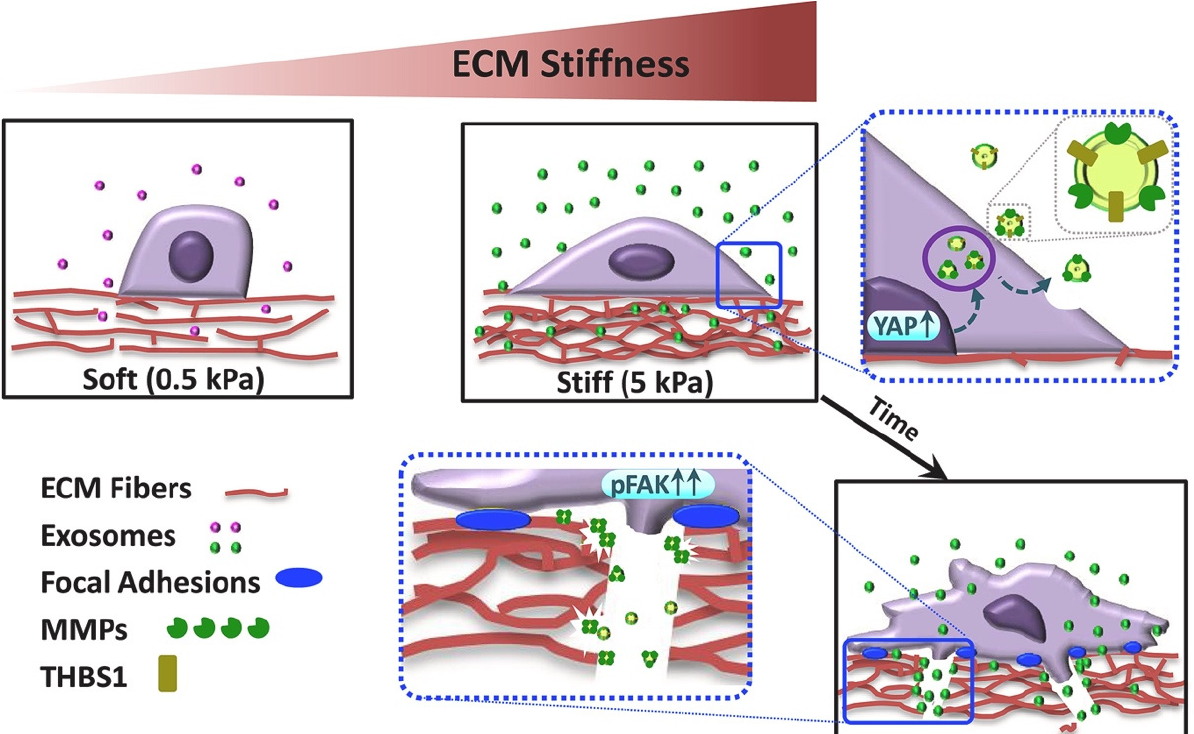
Figure 3. Proposed model of regulation of stiffness-dependent cancer invasiveness by stiffness-tuned exosomes. Breast cancer cells, in response to stiff substrates (5 kPa), secrete an excessive number of exosomes due to the activation of YAP/TAZ signaling. The stiffness-tuned exosomes confer an invasive, mesenchymal-like phenotype, accompanied by fostered focal adhesions and ECM remodeling. These changes are majorly elicited by exosomal THBS1 in concert with FAK and MMPs. Copyright 2021, with permission from Elsevier [146] .